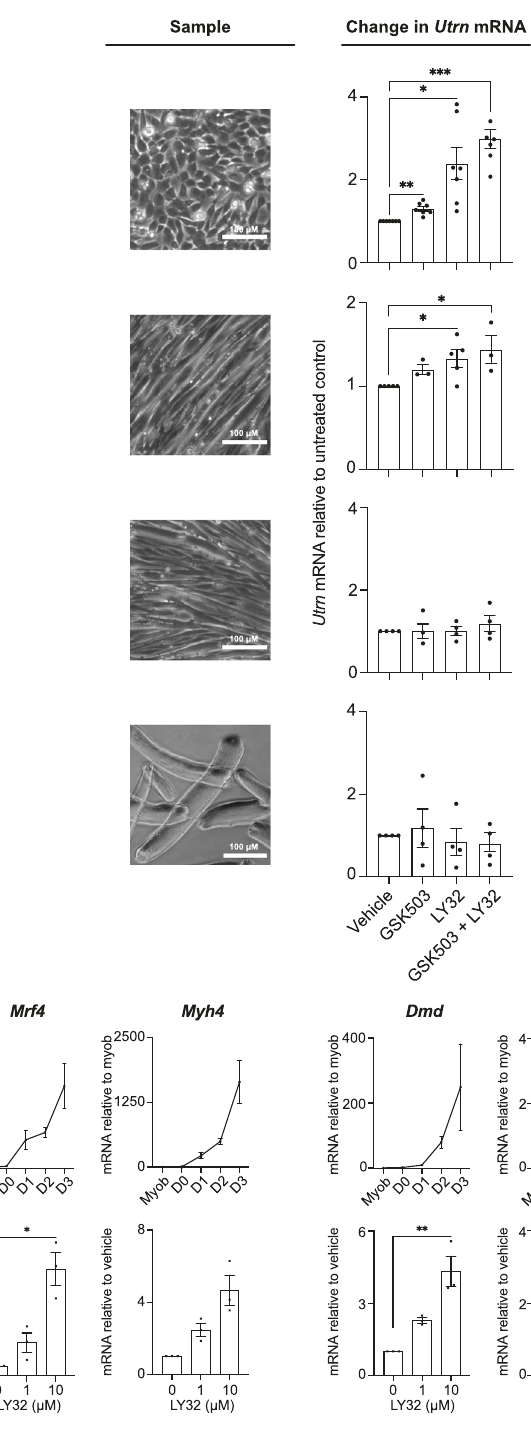
Fig. 6 Utrn -induction by ERK1/2 and EZH2 inhibitors is selective for myoblast stages and is sustained following differentiation. a Schematic showing different types of muscle cells that were isolated and cultured (left) before being exposed to GSK503 or LY32 alone (10 μ M) or in combination. Expression of Utrn mRNA was quanti fi ed by RT-qPCR after 24 h (right) and a representative phase contrast image of the cells at the time of sampling is shown (middle). As shown in Fig. 5d treatment of proliferating U22 A5 myoblasts with these drugs induced Utrn expression (upper panel), which was maintained following differentiation (72 h serum depletion, 2nd panel), while cultured myotubes (3rd panel) or ex vivo myo fi bres (lower panel) were unresponsive. Utrn mRNA levels were normalised to 18 S and Tbp , and expressed relative to vehicle treated samples. One-way ANOVAs ( p = 0.0012, p = 0.028, p = 0.75, p = 0.8) with Dunnett ’ s multiple comparisons test was used to compare between groups. b RT-qPCR analysis of the temporal expression of genes associated with speci fi c stages of myoblast differentiation in U22 A5 myoblasts upon serum depletion (upper panels), and corresponding gene expression responses to 0, 1 μ M and 10 μ M ERK1/2 inhibitor LY32 (lower panels). Serum-deprived samples (upper) are normalised to Csnk2a2 while drug- treated samples (lower) were normalised to 18 S and Tbp . One-way ANOVAs with Dunnett ’ s multiple comparisons test were used to compare vehicle and treated groups. Graphs show mean + / − SEM with adjusted p -values: * p < 0.05, ** p < 0.01, *** p <